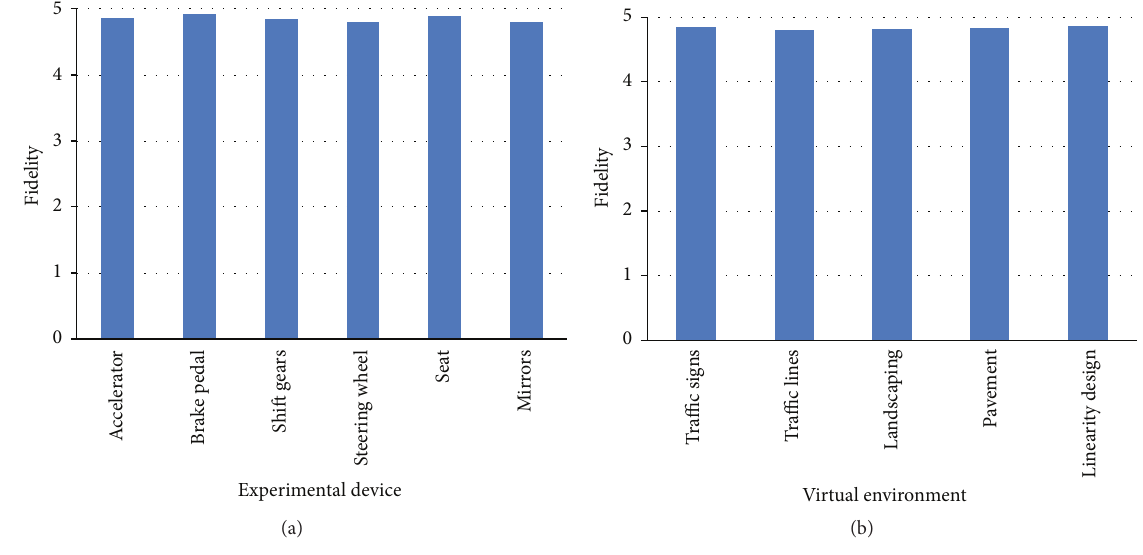
Figure 4: Fidelity evaluation results. (a) Experimental device. (b) Virtual environment. Table 2: Descriptive statistics of key